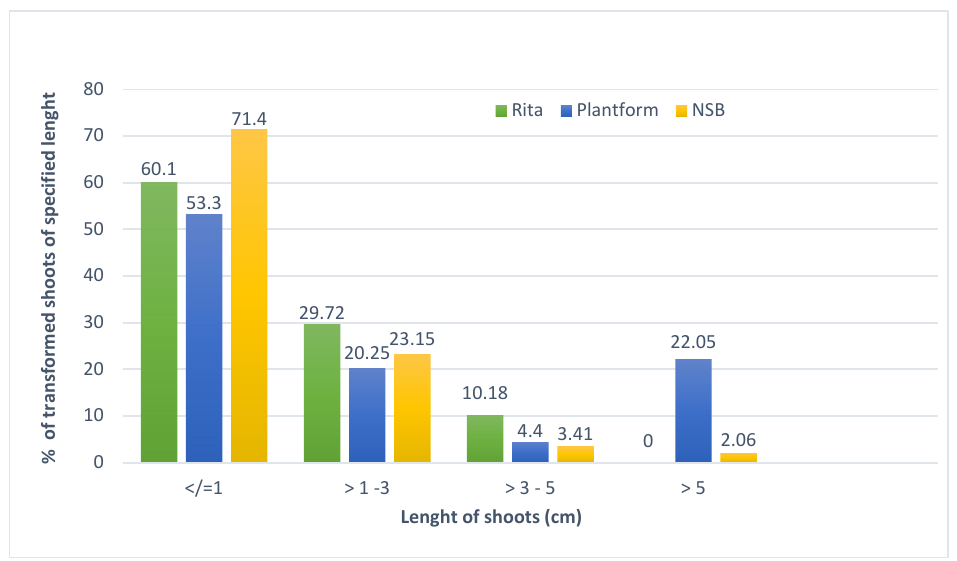
Figure 1. The length of D. forrestii transformed shoots after 3 weeks in different bioreactor systems in MS medium with BPA 0.5 mg/L and IAA0.2 mg/L.